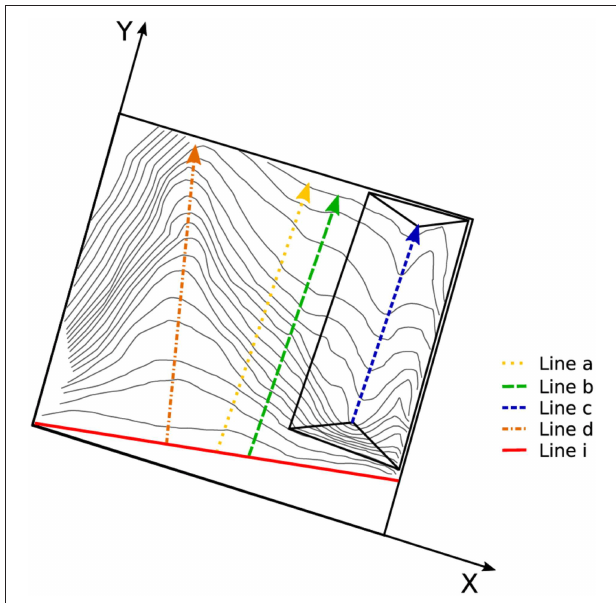
FIGURE 5 | The measurement directions of the fire propagation. The isochrones correspond to test SC324 ( α = 30 ◦ , γ = − 20 ◦ , β = 10 ◦